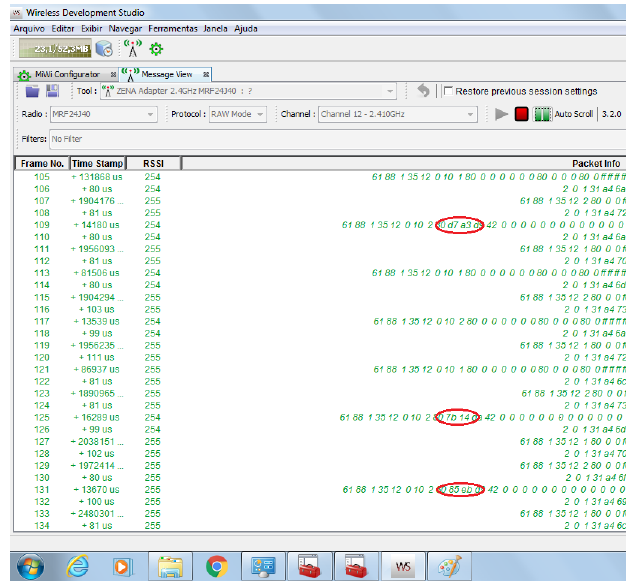
Figure 15. Screenshot of the data packets captured by the WDS